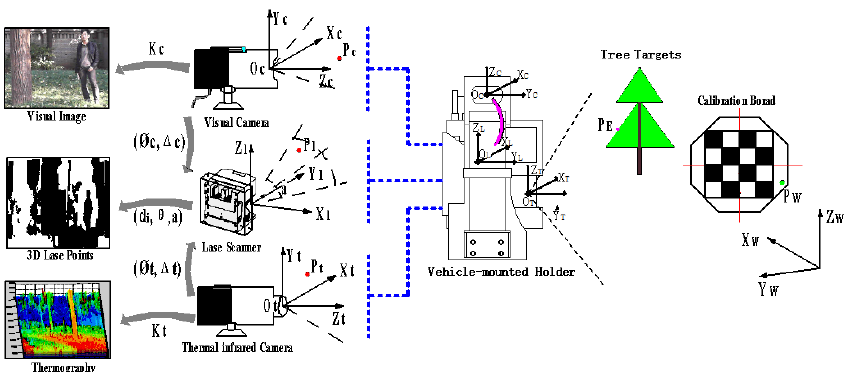
Figure 3. The joint calibration schematic of the thermal infrared camera, visible camera and 3D laser scanner for HFD.